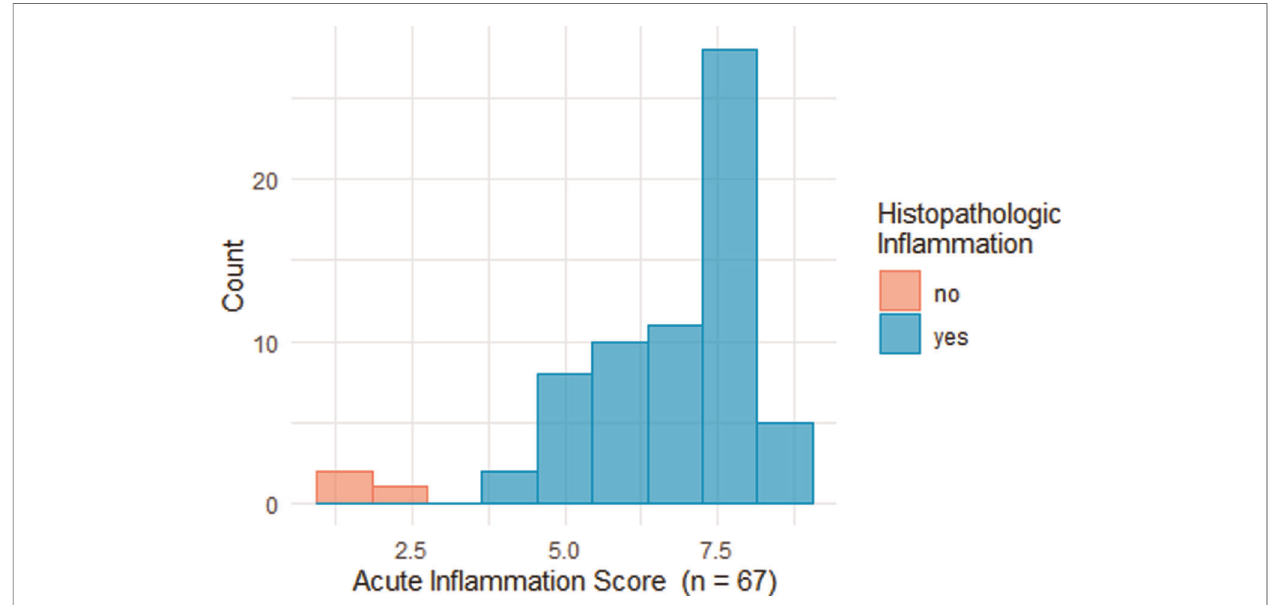
FIGURE 2 | Histogram of acute in fl ammation scores. Histopathological fi ndings are indicated by different colors: red – no signs of acute in fl ammation; turquoise: the presence of acute in fl